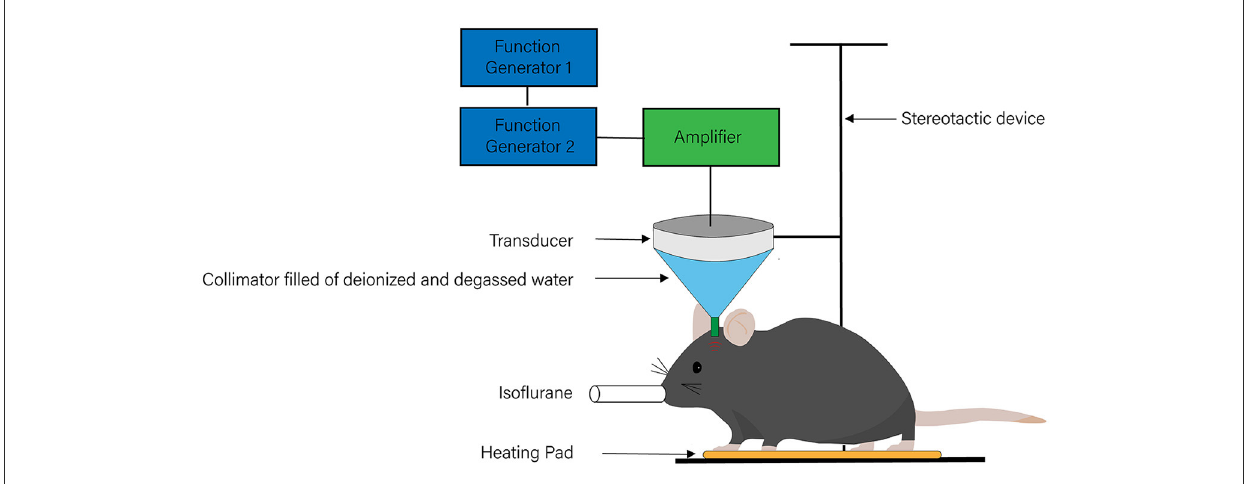
FIGURE1 The system of transcranial ultrasound stimulation. The system of transcranial ultrasound stimulation mainly includes a signal generator, a radio-frequency power amplifier, an ultrasonic transducer, a hydrophone, a transducer fixing device, and an ultrasonic coupling agent.